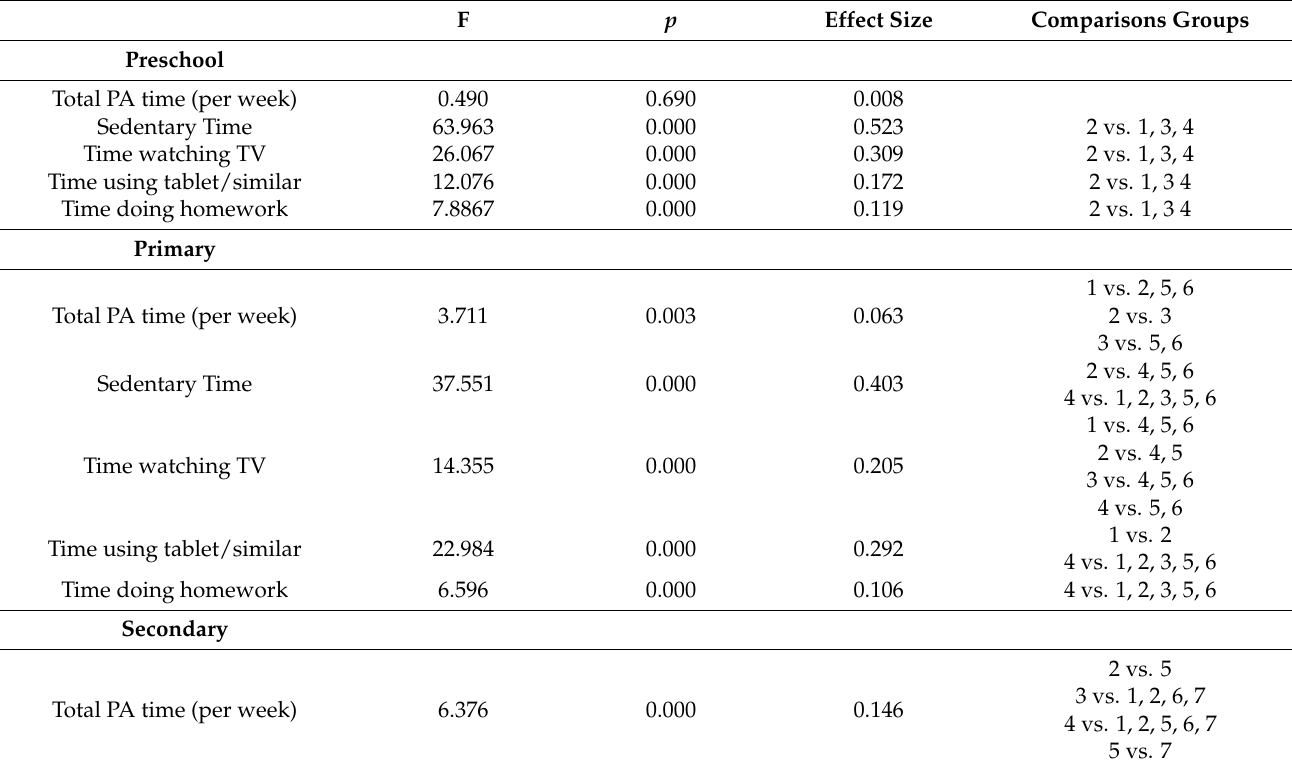
Table 2. Differences in the variables (one-way ANOVA) in the different clusters at each educational level. F p Effect Size Comparisons